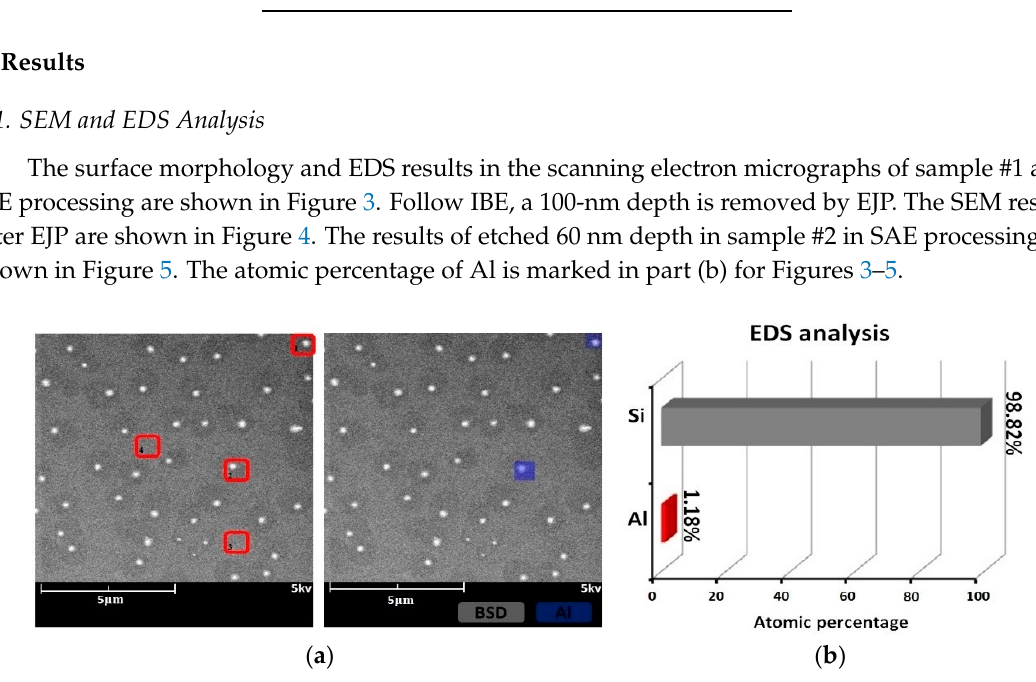
Figure 3. Sample #1 after IBE processing: ( a ) morphology result and ( b ) EDS result.